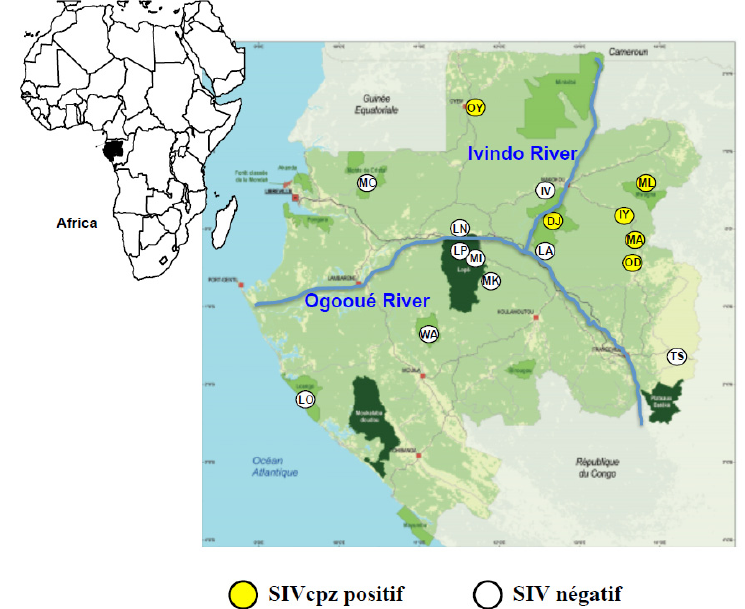
Figure 1. Geographical distribution of chimpanzee faecal samples collection sites (white and yellow circles) from Gabon Locations of faecal samples collection: LO = Louango, WA = Waka, MK = Makande, MI = Mikongo, LP = Lopé National Park, LN = Lopé SEGC site, MC = Monts de Cristal, OY = Oyem, IV = Ivindo, DJ = Djidji, LA = Langoué, TS = Tsouba, OD = Odjala, Ma = Makatamangoye, IY = Iyoko milieu, ML = Malouma. Yellow circles represent sites where SIVcpz positive samples were identified.